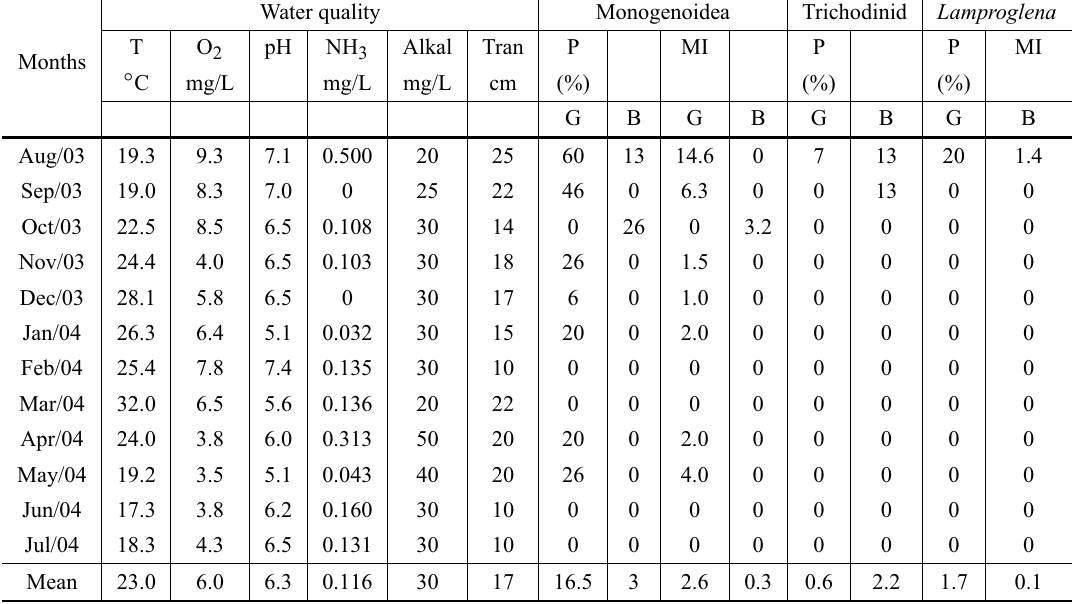
Water quality and parasitic characteristics of Nile tilapias (n=180) kept in fee fishing system from Valley of Tijucas River, Santa Catarina, Brazil. T: temperature; O 2 : dissolved oxygen; NH 3 : ammonia; Alkal: alkalinity; Tran: transparency; P: prevalence; MI: mean intensity; G: gill; B: body surface.